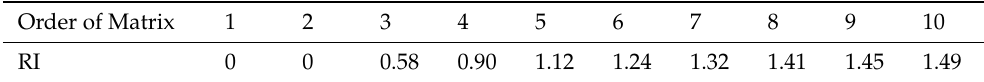
Table 1. The standard values of RI. Order of Matrix RI After verification, the subjective weight is calculated by Equation (9) as